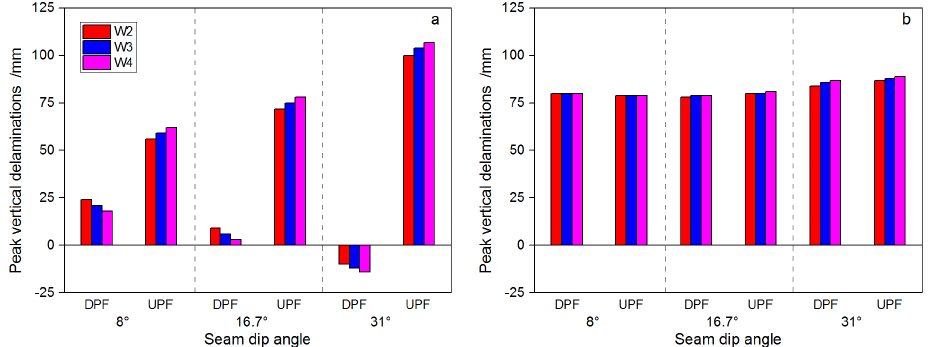
Figure 14. Peak vertical delaminations of well trajectories W2–W4 at the inclined interfaces in longwall mining along strike after only one panel ( a ) and then the second panel is removed ( b ) in cases of a different extraction sequence. “DPF” represents that the downdip panel is removed first and then the updip panel. “UPF” represents that the updip panel is removed first and then the downdip panel.